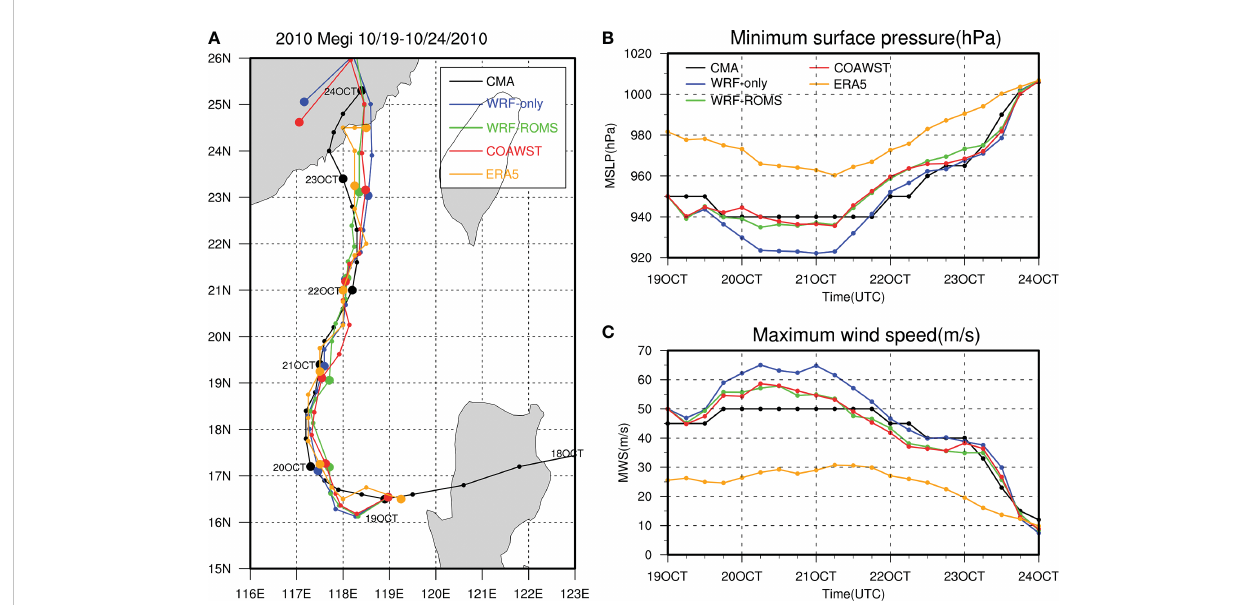
FIGURE 2 (A) Track of Typhoon Megi with every 6-h position, (B) the storm ’ s central minimum sea level pressure (hPa), and (C) the maximum sustained 10-m wind speed (m s − 1 ) from 00 UTC 19 Oct to 00 UTC 24 Oct 2010. The results based on CMA best-track data are shown in black, and the simulation results of other experiments are also shown in blue, green, and red for WRF-only, WRF-ROMS, and COAWST,